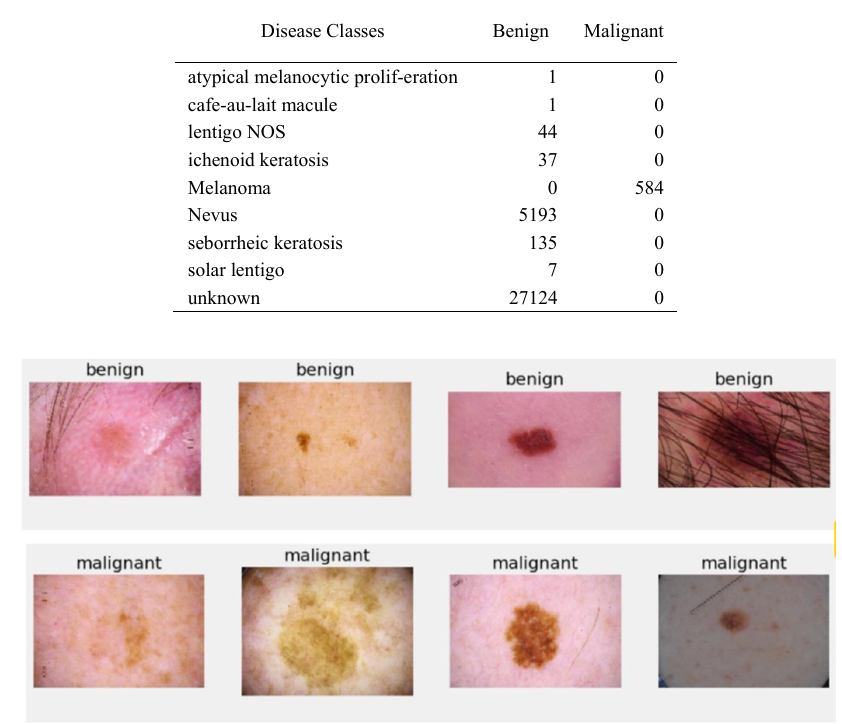
Fig. 7 Images of Benign and Malignant Skin Cancers